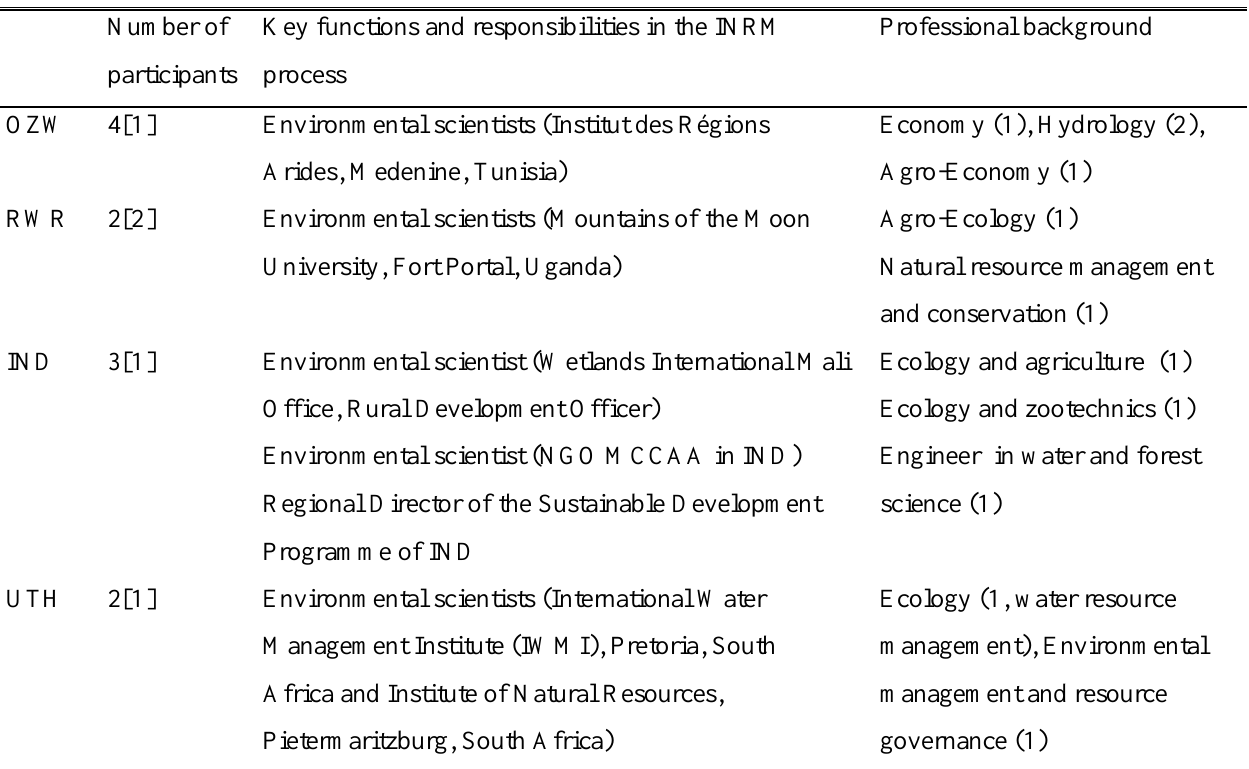
Table A2.1: Information on local researchers who participated in the survey, with the number of co- authors given in square